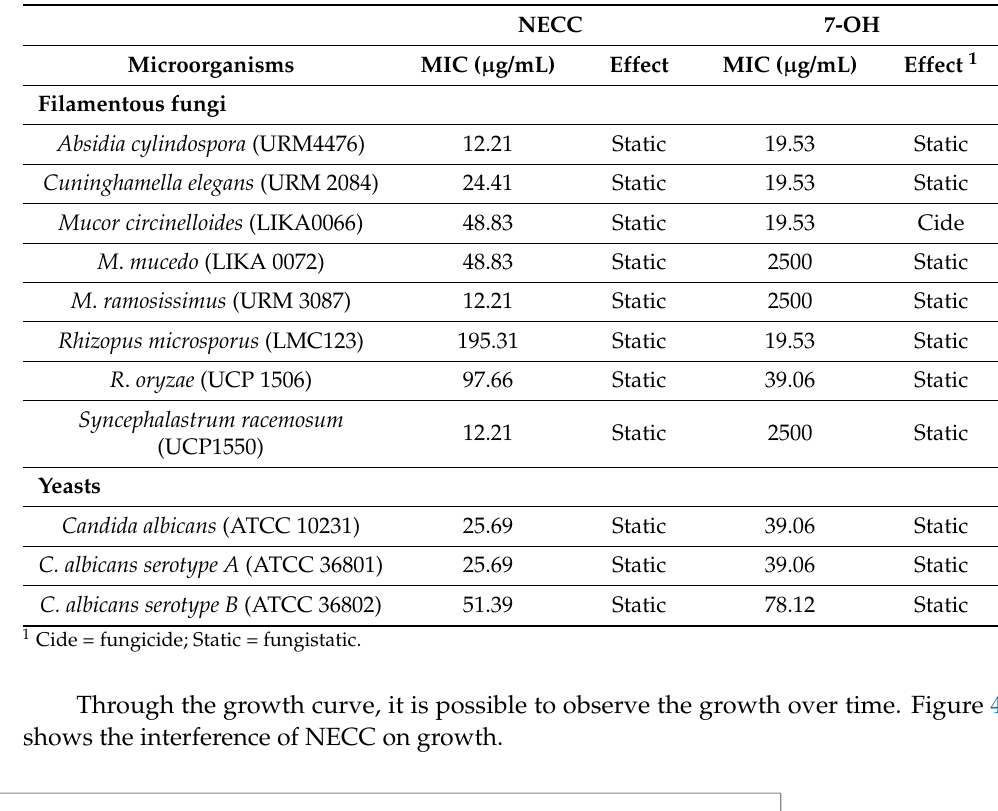
Table 2. Minimal inhibitory concentration (MIC) of NECC and 7-hydroxycalamenene (7-OH).